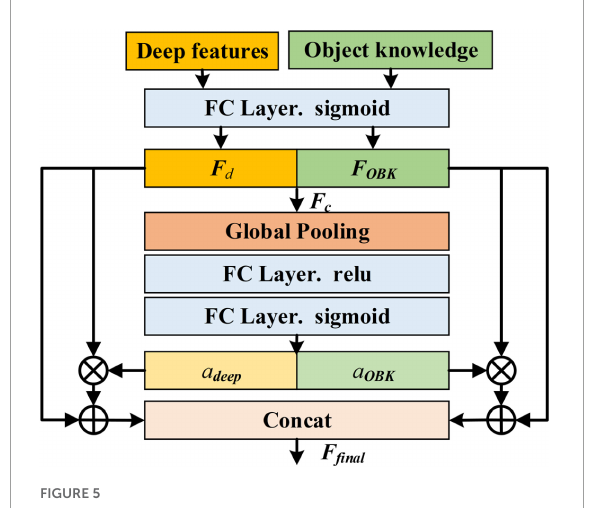
FIGURE5 Illustration of attention-based injection method ( ⊗ represents Hadamard product; ⊕ denotes element-wise addition).